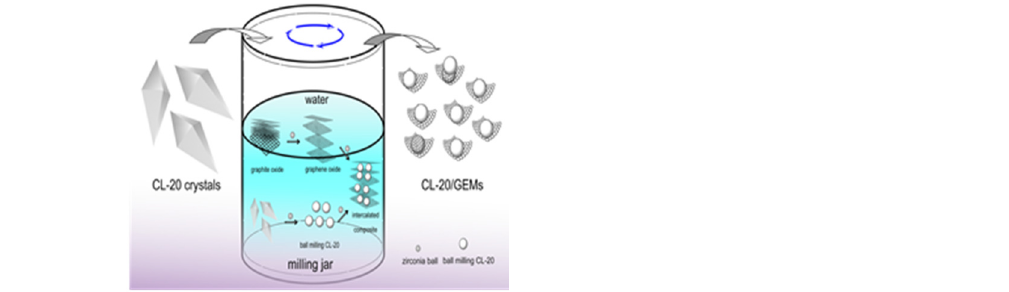
Figure 5. The production scheme of HMX/graphene composite material.